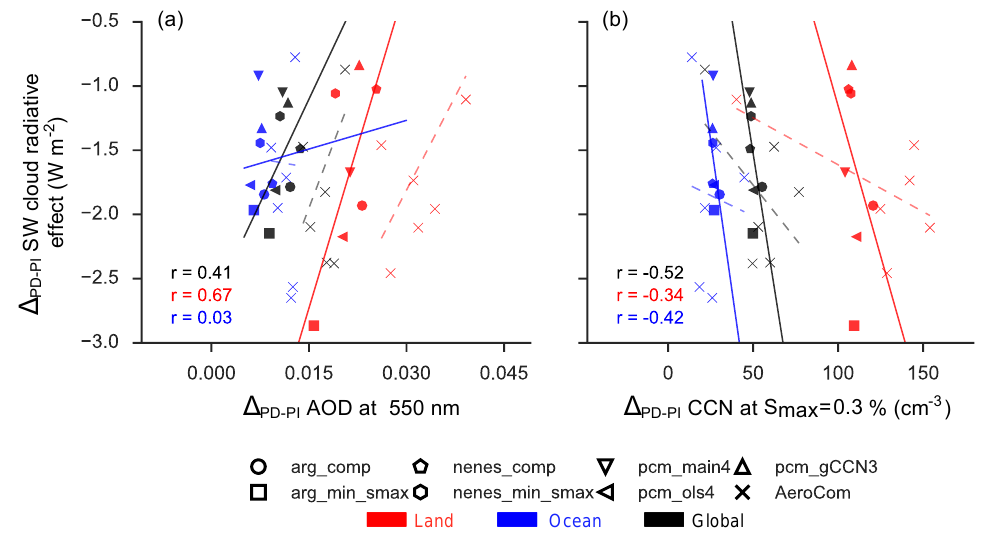
Figure 9. Relationship between regionally averaged PD–PI change in SW CRE and aerosol optical depth (a) or CCN concentration (b) . Colors denote averages over all land area (red), ocean (blue), or the whole globe (black). Glyphs denote MARC simulations with different activation schemes; X denotes AeroCom model. Linear regressions for MARC simulations are represented by solid lines, with the corre- sponding correlation coefficient indicated on the plot; linear regressions for AeroCom models are given by the dashed lines.